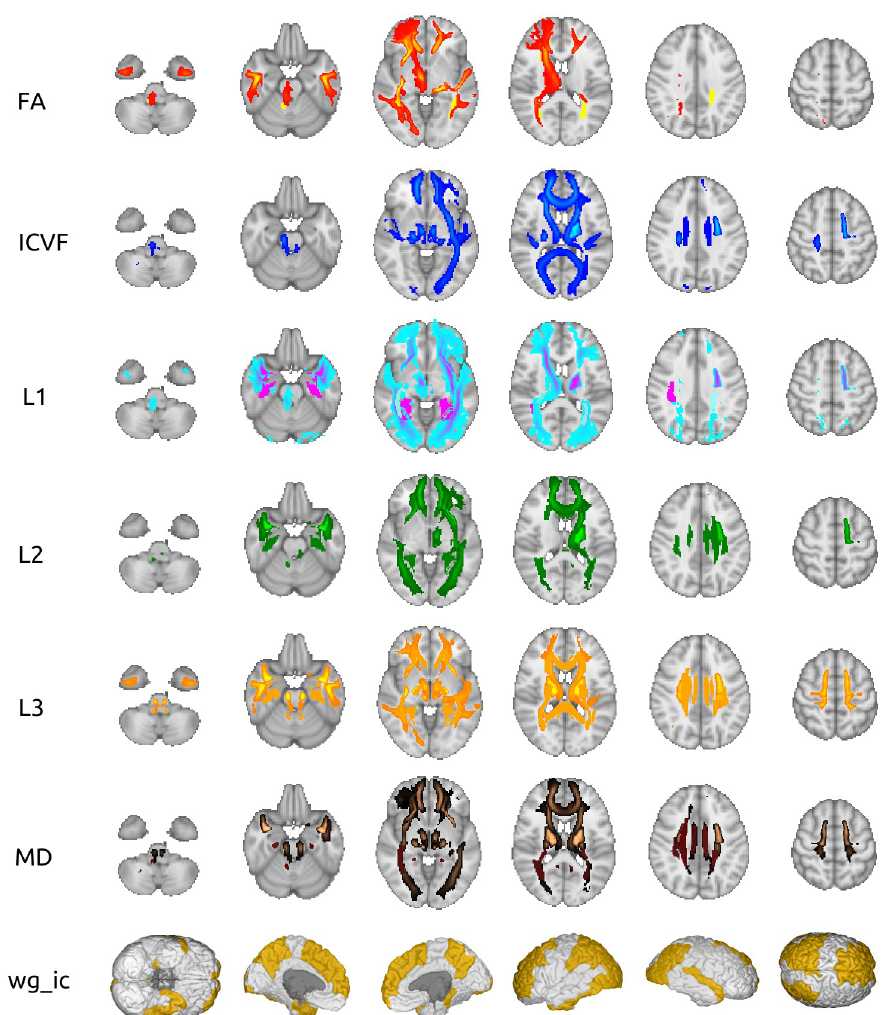
Fig 2. Visual representation of the significant IDPs among the seven most prevalent measures. For the six diffusion indices (top six rows) the tracts that are significantly associated with TL are highlighted. The last row shows the cortical regions with a significant effect of TL on gray-white matter intensity contrast. Different colors within a diffusion measure relate to IDPs extracted from two different methods: tract-based spatial statistics (solid colors) and probabilistic tractography (color gradients). The plots were generated by BrainPainter [10] and FSL [11].